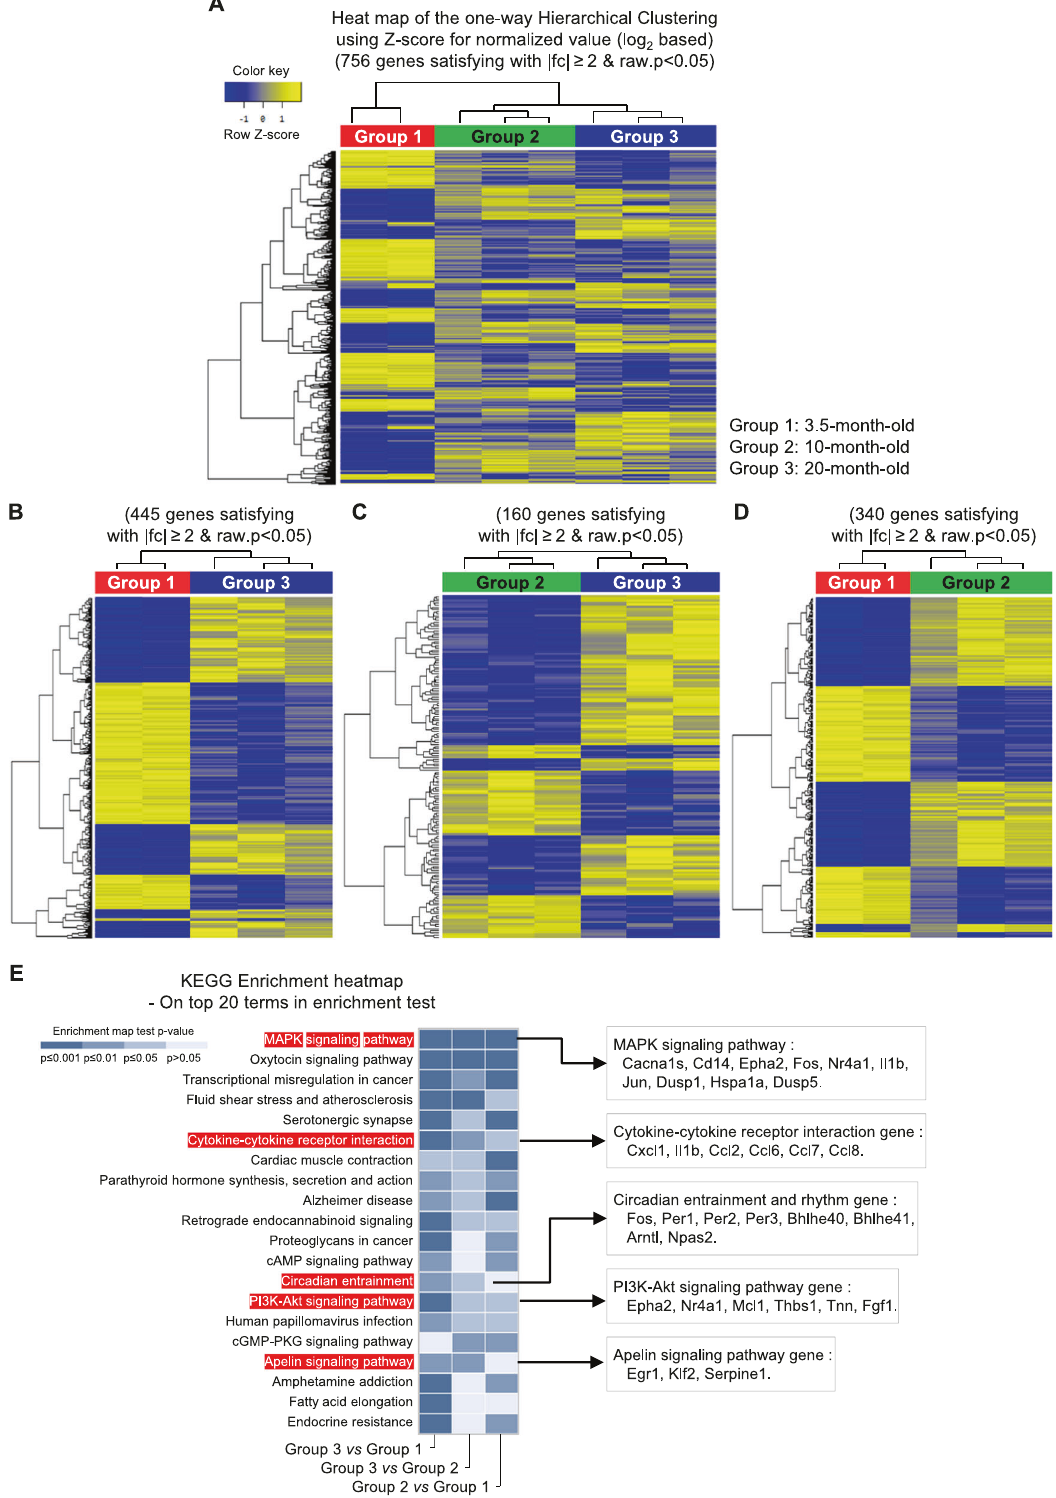
Fig. 1 Gene expression-based change of the thyroid glands in 20-month-old mice. A Hierarchical clustering heatmap of differential gene expression. Heatmap of one-way hierarchical clustering using the expression for a total of 756 unigenes (rows) satisfying the arbitrary criterium of a ≥ 2-fold change in expression and a raw p -value < 0.05 in eight samples (columns). Expression levels of each unigene across samples are presented as row Z score calculated by FPKM from RNA sequencing. B Group 1 (3.5 months of age) and Group 3 (20 months of age) differential gene expression. C Group 2 (10 months of age) and Group 3 (20 months of age) differential gene expression. D Group 1 (3.5 months of age) and Group 2 (10 months of age) differential gene expression. E Heatmap of KEGG pathways enrichment scores of DEGs in each comparison combination.